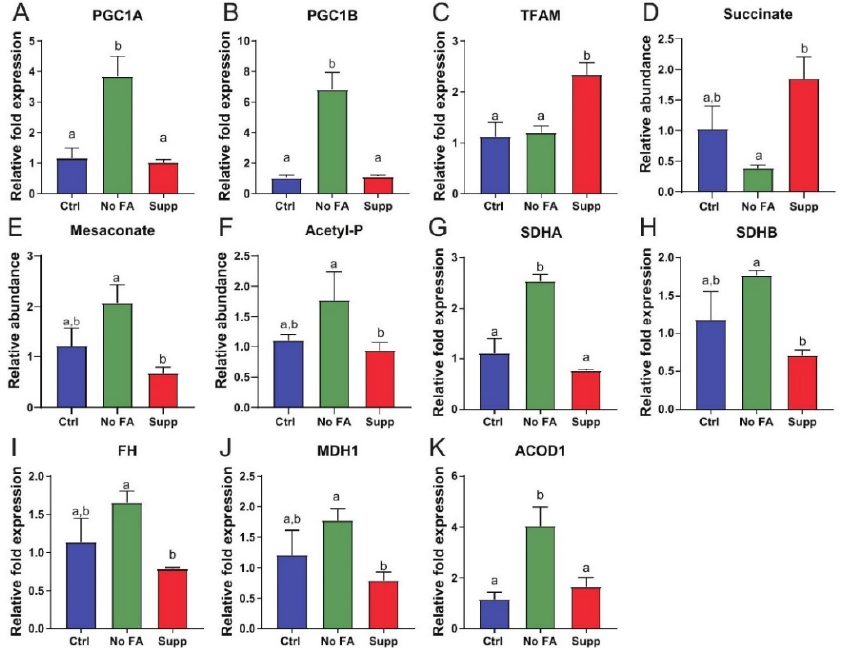
Figure 5. FA restriction enhances mitochondrial dysfunction in MDA-MB-231 tumors. Expression of PGC1α ( A ), PGC1ß ( B ), and TFAM ( C ) measured by qPCR in tumors from each diet group (n = 5/group). Relative abundance of succinate ( D ), mesaconate ( E ), acetyl-P ( F ) MDA-MB-231 tumors from control (Ctrl, 2 ppm FA), FA-deficient (No FA, 0 ppm FA), or FA-supplemented (Supp, 12 ppm FA) diets (n = 6 samples/group). Expression of SDHA ( G ), SDHB ( H ), FH ( I ) and MDH1 ( J ), and ACOD1 ( K ) measured by qPCR in tumors from each diet group (n = 5/group). One-way ANOVA used to determine statistical significance ( p < 0.05), different letters indicate significant differences.